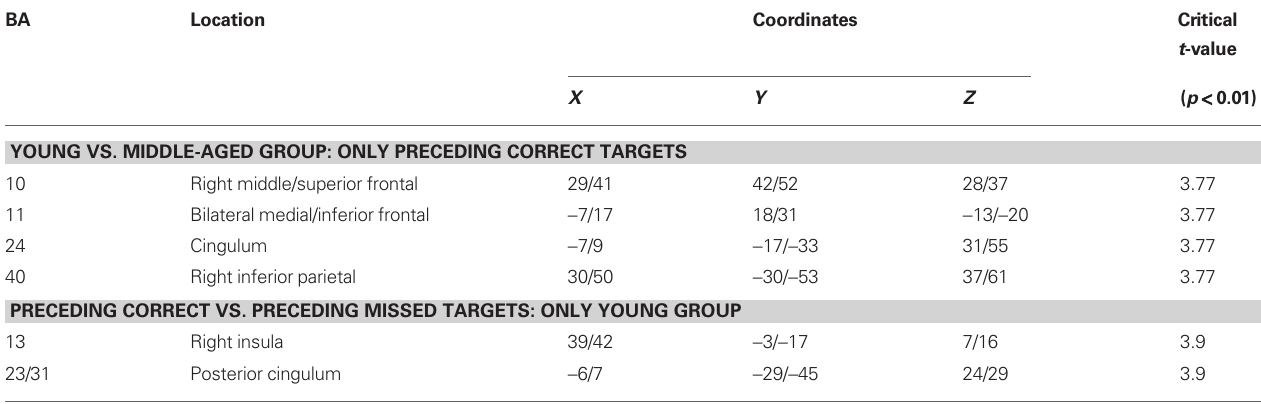
Table 2 | summary of the sLoreTa results of the P300 to non-targets which directly preceded targets in the 2-back task. ba Location coordinates critical t -value X Y Z ( p < 0.01) Young vs. MiddLe-aged grouP: onLY Preceding correcT TargeTs